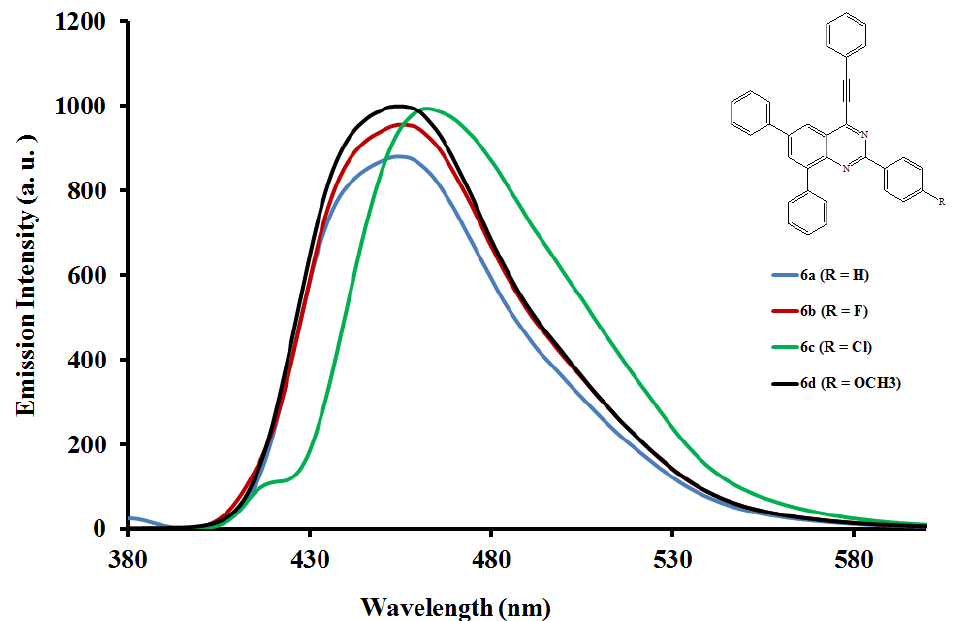
Figure 4. The emission spectra of compounds 6a – d ( λ ex = 380 nm) in CHCl (0.022 mmol/L) at rt.